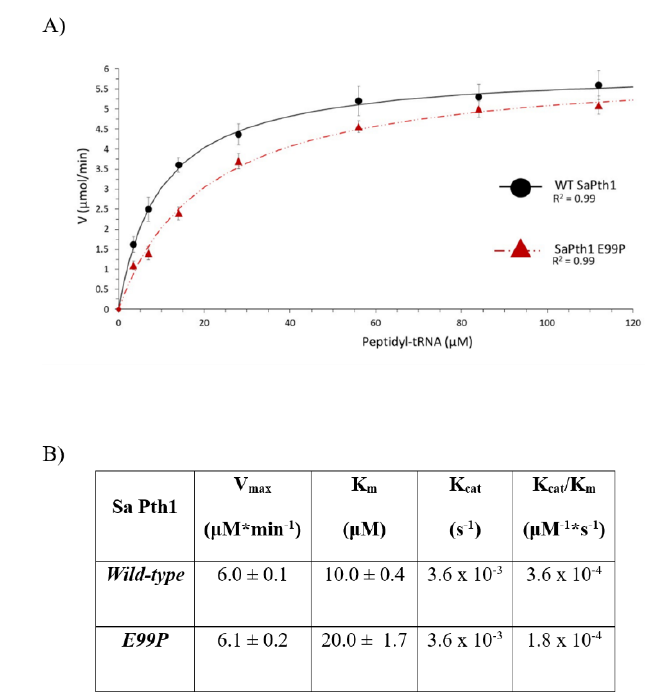
Figure 9. S. aureus Pth1 Gate Loop Mutation Affects K m but not V max or K cat . ( A ) The velocity of substrate cleavage for wild-type S. aureus Pth1 (black circles) is compared to the mutant E99P S. aureus Pth1 (red triangles). ( B ) Table showing a summary of kinetic parameters.